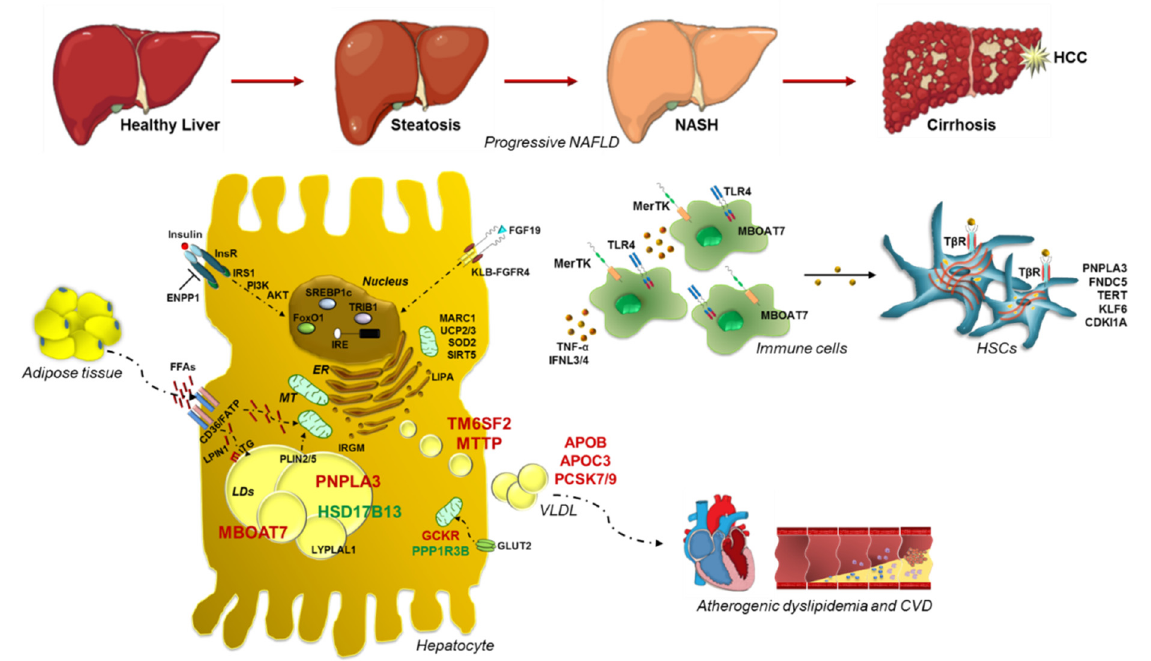
Figure 1. Impact of genetics in NAFLD pathogenesis and progression towards advanced liver damage. Schematic illustration of the most relevant inherited variations involved in progressive NAFLD, shedding light into their functional effects. PNPLA3, localized at the LD surface in hepatocytes, catalyzes TG hydrolysis. The p.148M variant enhances hepatic TG content upon mutant protein accumulation, hampering TG turnover and dismissal. TM6SF2 is implicated in VLDL formation in ER and release, whereas MBOAT7 transfers arachidonoyl-CoA to Lyso-PI, maintaining membrane fluidity. Their variations dampen VLDL secretion and membrane dynamism, respectively. Viceversa , genetic variants in HSD17B13 and PPP1R3B may exert a protective effect against NAFLD. Heritable variations may also influence glucose and insulin signaling, FFA uptake, fat deposition and VLDL turnover, precipitating fatty liver. In addition, IR and elevated FFAs derived from adipose tissue lipolysis exacerbate fat depot formation induced by genetic modifiers, even activating DNL. Recently, common SNPs in modulators of mitochondrial (MT) function have been proposed as active players in the switching from steatosis to NASH and fibrosis, further corroborating the role of organelle abnormalities in these processes. Furthermore, variants in genes regulating inflammatory response and HSCs activation may precipitate fatty liver to worsened conditions. Finally, genetically determined perturbations in circulating lipids may trigger cardiovascular comorbidities. Dotted lines refer to influx and efflux processes into the hepatocyte, whereas solid lines refer to cell activation or to the transition from simple steatosis up to cirrhosis-HCC. Table 1. Schematic list of the main inherited variations related to the histological hallmarks of NAFLD. Variant